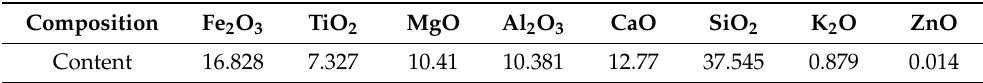
Table 3. Chemical composition analysis results of the ore sample (wt.%).